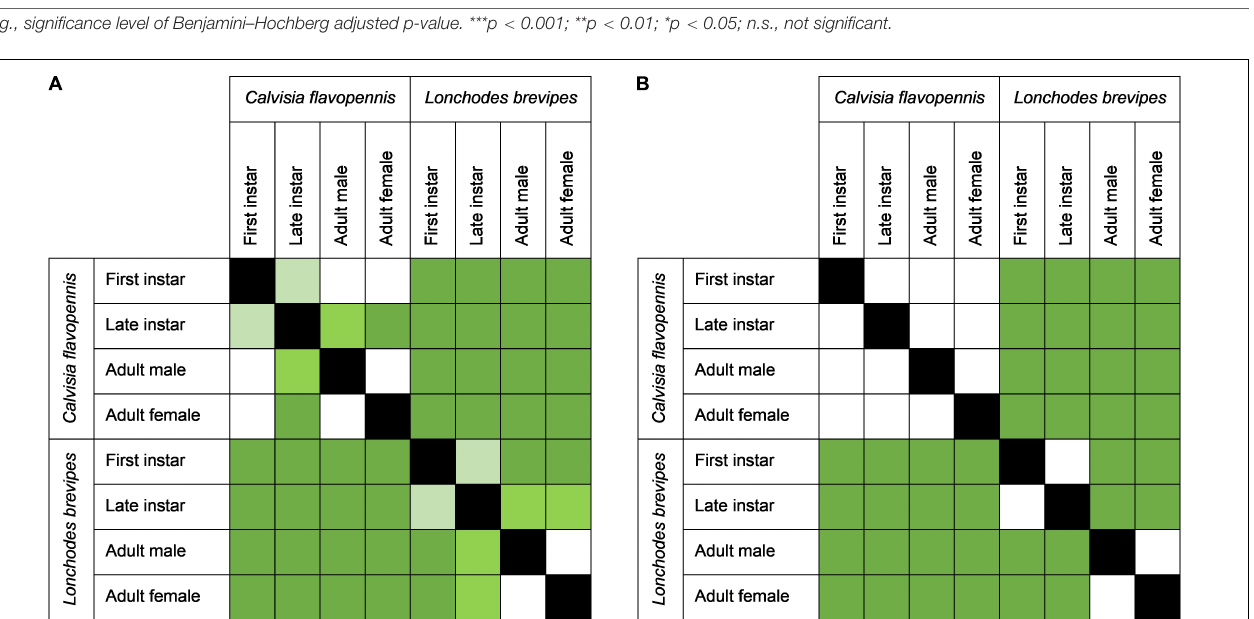
as well as than adult male L. brevipes and first instar and adult male C. flavopennis in the control treatment (all p <